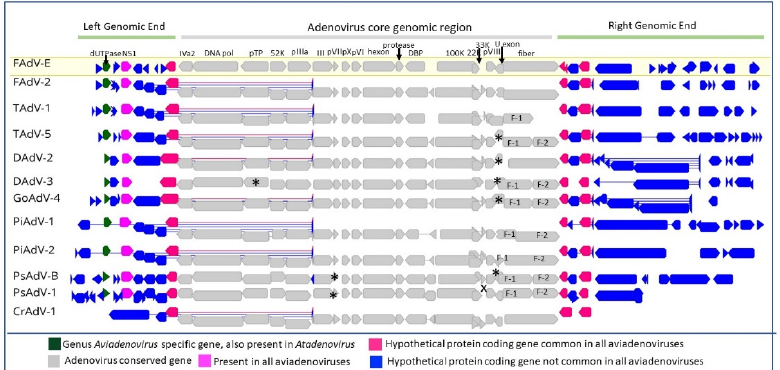
Figure 5. Schematic illustration of aviadenovirus genome comparison. Complete aviadenovirus genomes were extracted from the following: NCBI ( Fowl aviadenovirus E (FAdV-E), GenBank Ac No. KT862808; Fowl aviadenovirus D (FAdV-D), GenBank Ac No. KT862805; Turkey aviadenovirus B (TAdV-B), GenBank Ac No. GU936707; Turkey aviadenovirus D (TAdV-D), GenBank Ac No. KF477313; Duck aviadenovirus B (DAdV-B), GenBank Ac No. KJ469653; Duck adenovirus 3 (DAdV-3), GenBank Ac No. MW677606; Goose aviadenovirus A (GoAdV-A), GenBank Ac No. JF510462; Pigeon aviadenovirus A (PiAdV-A), GenBank Ac No. MW286325; Pigeon aviadenovirus B (PiAdV-B), GenBank Ac No. KX121164; Psittacine aviadenovirus B (PsAdV-B), GenBank Ac No. KX577802; Psittacine aviadenovirus C (PsAdV-C), GenBank Ac No. MH580295 and crane-associated adenovirus 1 (CrAdV-1), GenBank Ac No. LC469780); they were aligned with MAFTT (version 7.388) [21] in Geneious Prime ® (version 2022.1.1, Biomatters, New Zealand). Conserved adenovirus genes, genus common and species-specific hypothetical ORFs and genes shared by both avidenovirus and mastadenoviruses were presented in different colours, as per the given guide. Conserved genes that are not present in genomes are marked with X, and genes present but not annotated are represented with a star (*). F-1 and F-2 are the abbreviations for fibre 1 and 2,